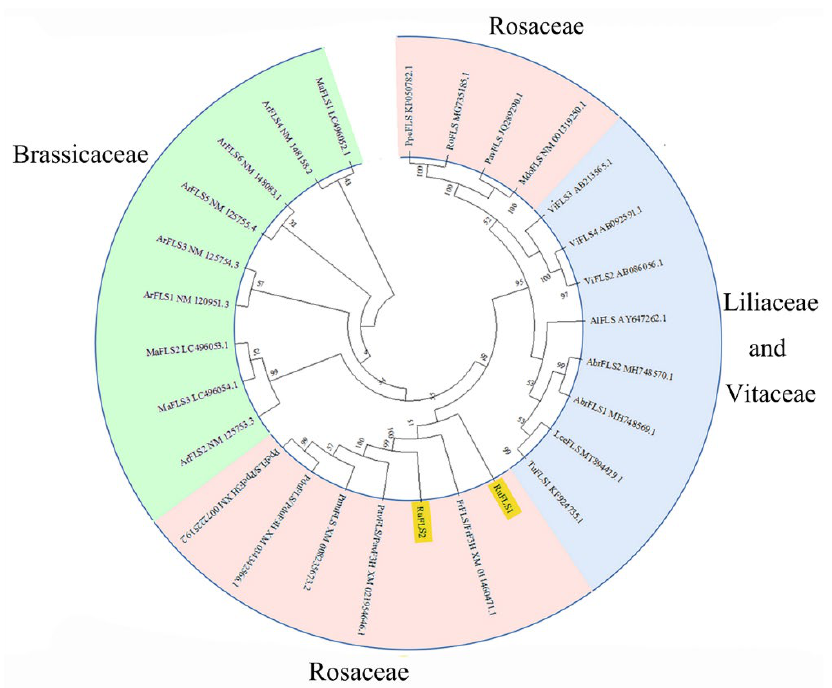
Figure 3. Phylogenetic tree of blackberry RuFLSs (RuFLS1 and RuFLS2) and FLS genes from other species. The rings of different colors represent different genera.